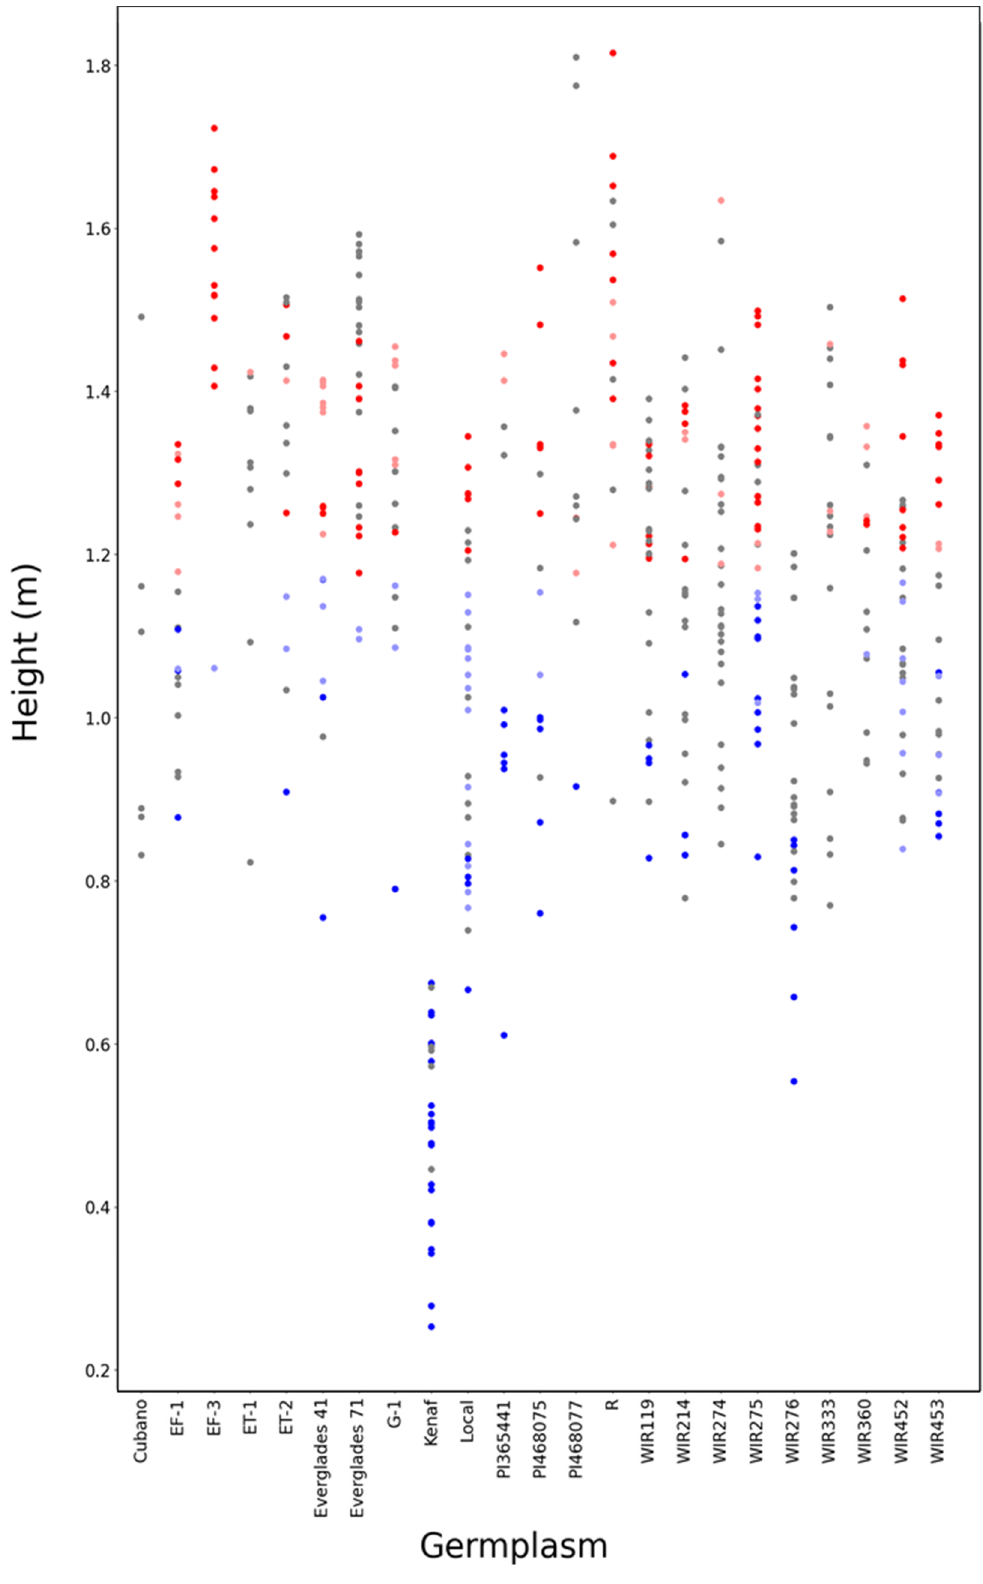
Figure 4. The height distribution of each germplasm including the result from spatial autocorrelation analysis (LISA).